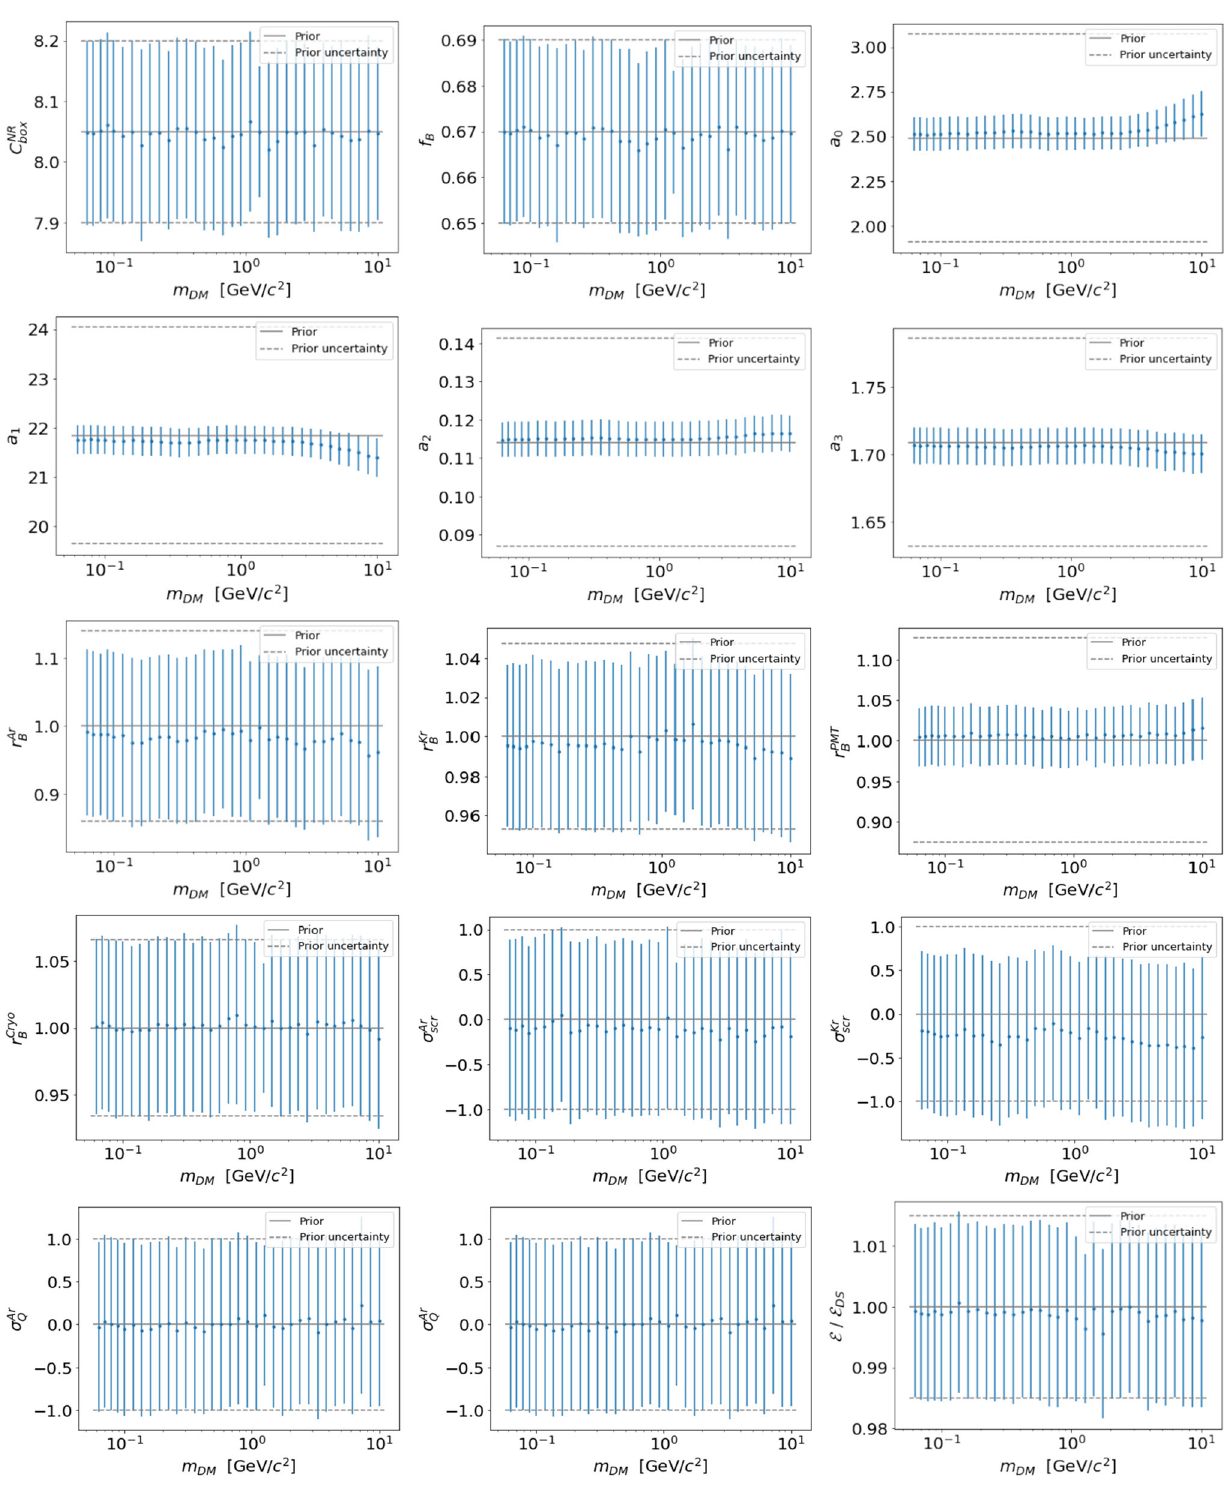
Fig. 11 Evolution of the posterior pdf s as a function of the DM mass. The blue points represent the mean of the posterior pdf and their uncer- tainty bar is the correspondent standard deviation. In each plot, the gray